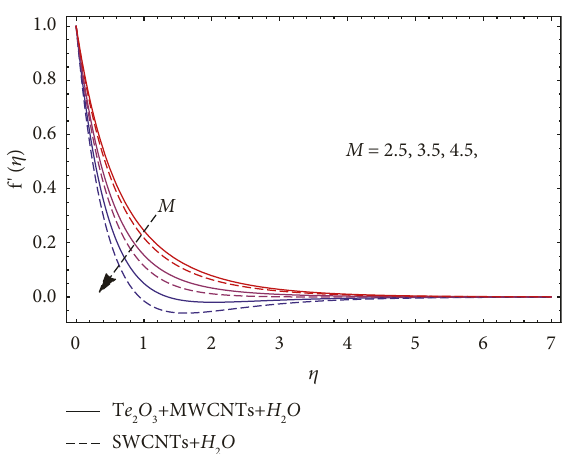
Figure 3: Influence of magnetic field parameter on velocity profile in x direction.